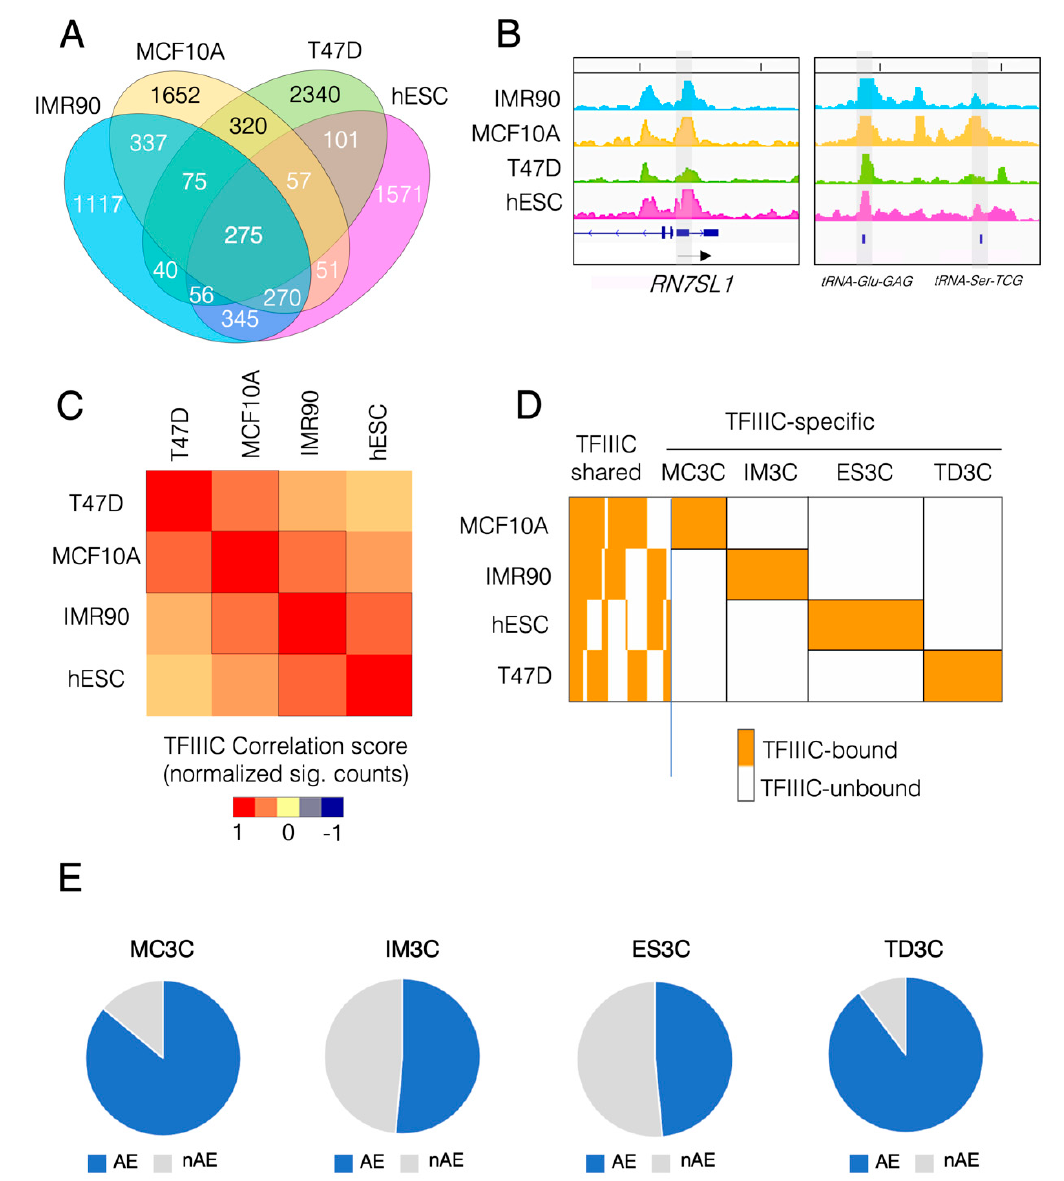
Figure 1. TFIIIC occupancy in several human cell lines displays marked cell type specificity and overlap with repetitive elements. ( A ) Venn diagram of the overlap among the genome-wide peaks for TFIIIC occupancy in the 4 human cell lines used in this study (IMR90, MCF10A, T47D and hESCs). ( B ) Genome browser view of ChIP-seq data for TFIIIC on two Pol III representative loci: the RN7SL1 gene and the gene for the tRNA-Glu-GAG (arrow indicates the direction of transcription). Highlighted in grey is the gene bound by TFIIIC in all 4 cell lines. Note that the gene for the tRNA-Ser-TCG is only occupied in MCF10A. ( C ) Matrix of Pearson’s correlation between TFIIIC ChIP-seq data across the cell lines indicated. Color scale indicates the correlation score based on normalized sig tags. ( D ) Heatmap of combinatorial occupancy of ChIP-seq of TFIIIC across all cell lines indicated. Each vertical line represents a genomic coordinate which could be bound (orange color) or not bound (white color) by the factor. Left side of the figure shows the TFIIIC-shared sites across all the cell line tested. Cell type-specific occupancy of TFIIIC (right part of the heatmap) has been highlighted by the black boxes and each set of genomic coordinates particular for each cell line has been named accordingly: MCF10A (MC3C), IMR90 (IM3C), hESCs (ES3C) and T47D (TD3C). ( E ) Pie charts showing the fraction of MC3C, IM3C, ES3C and TD3C that overlap with AE (AE) in blue and not overlapping with AE (nAE) in grey.